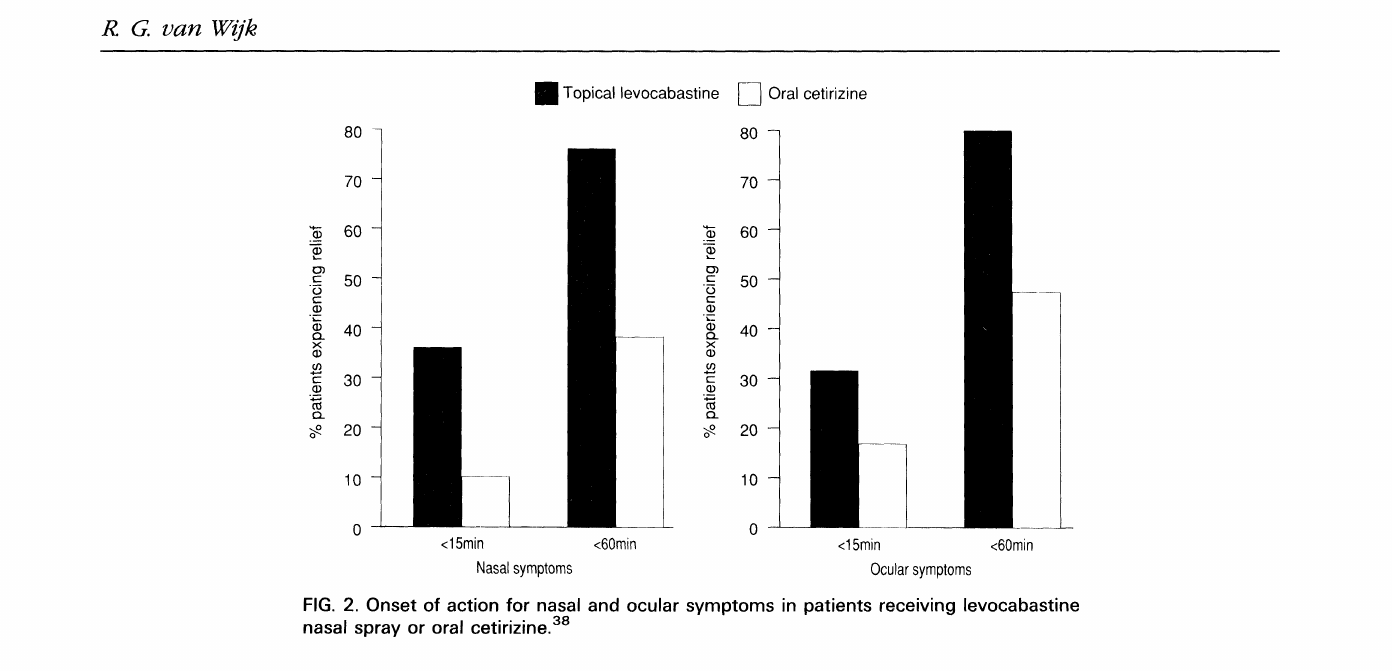
FIG. 2. Onset of action for nasal and ocular symptoms in patients receiving levocabastine nasal spray or oral cetirizine. 38